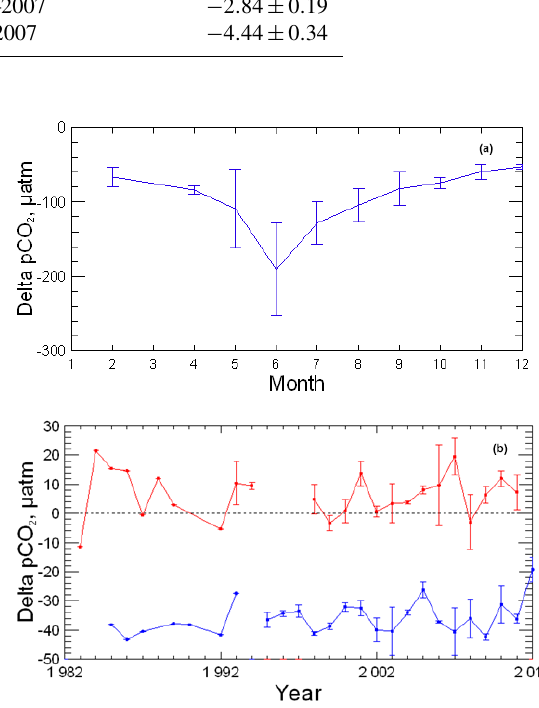
Figure 5. Water mass decadal surface water p CO 2 characteristics. (a) A composite picture of delta p CO 2 from 146 stations with Po- lar Water p CO 2 observations ( n = 312) from the 25m surface layer from 1983 to 2012 shows undersaturation at all times of the year. The error bars indicate ± 1 standard deviation from the monthly means. (b) Atlantic Water at the Irminger Sea time series station (red) is generally a weak CO 2 source in winter (24 winters, 52 samples), January–March, whereas winter (25 winters, 61 samples) CO 2 undersaturation persists at the Iceland Sea time series site (blue). The error bars indicate ± 1 standard deviation from the sur- face layer station